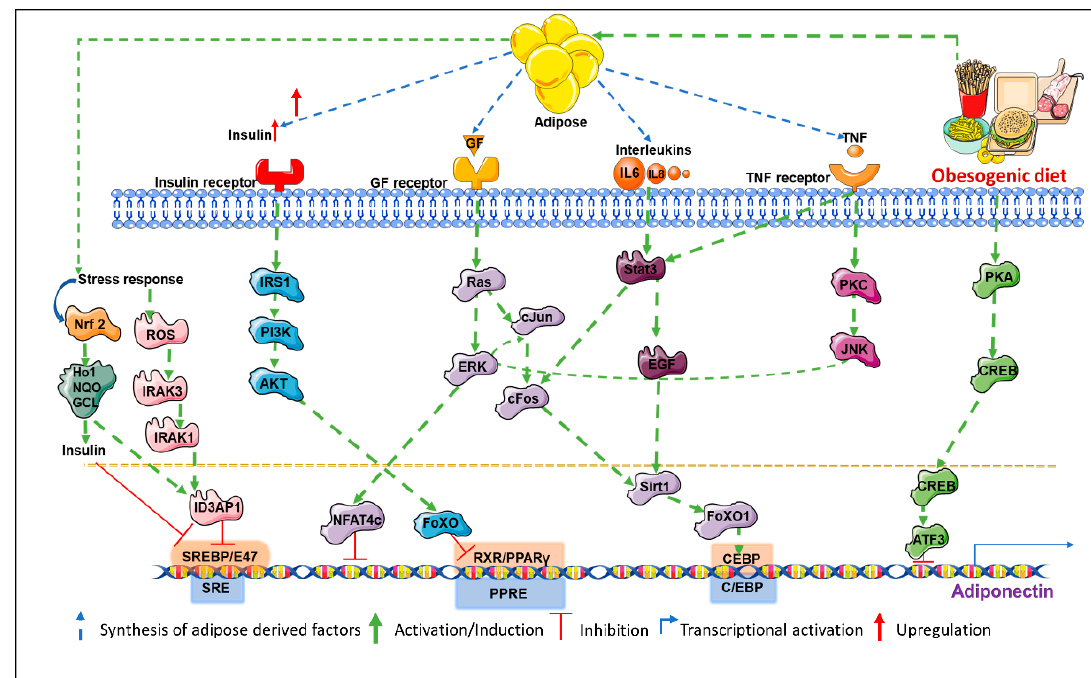
Figure 1. Multiple signaling networks converge to regulate adiponectin.